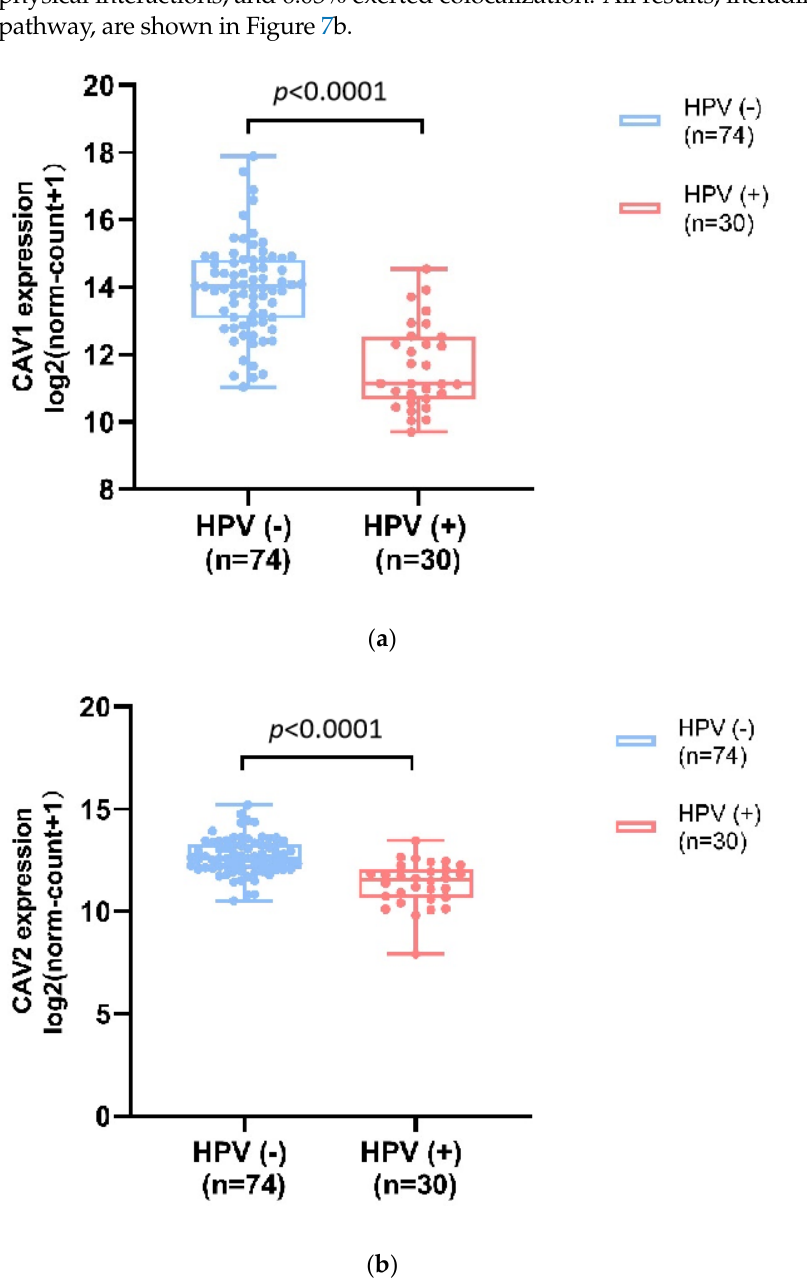
Figure 6. CAV1 and CAV2 mRNA expression levels were associated with HPV status. CAV1 (( a ), mean ± SD: HPV − :13.97 ± 1.36, HPV+:11.63 ± 1.26) and CAV2 (( b ), mean ± SD: HPV − :12.69 ± 0.88, HPV+: 11.33 ± 1.09) expression levels were significantly higher in HPV negative samples compared with those HPV positive samples RNA-seq data in TCGA-HNSC on the HPV status of patients by p16-testing was collected and analyzed by Welch’s t-test.